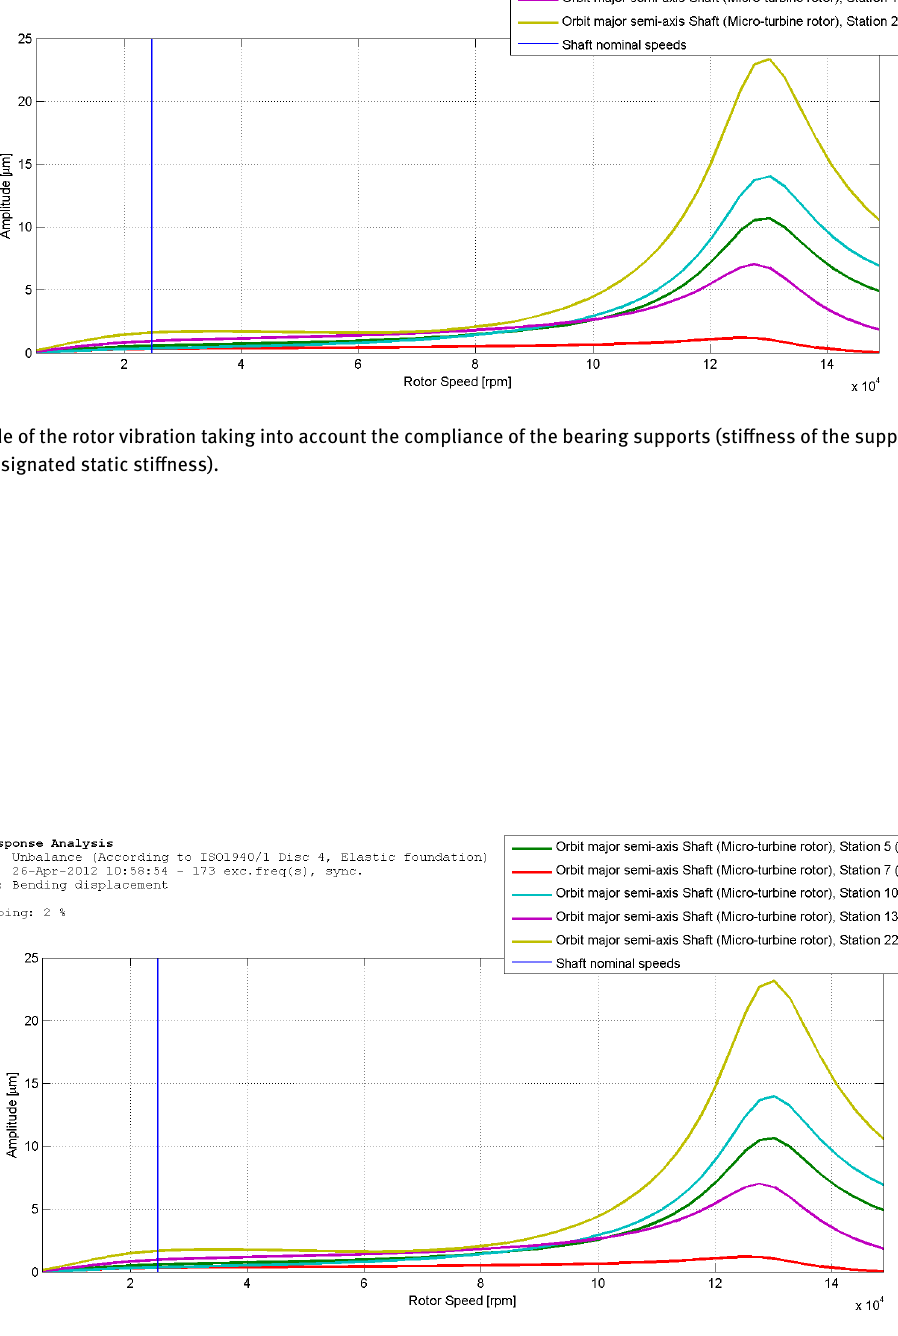
Figure 20: Amplitude of the rotor vibration taking into account the compliance of the bearing supports (stiffness of the supports was 10 times greater than the designated static